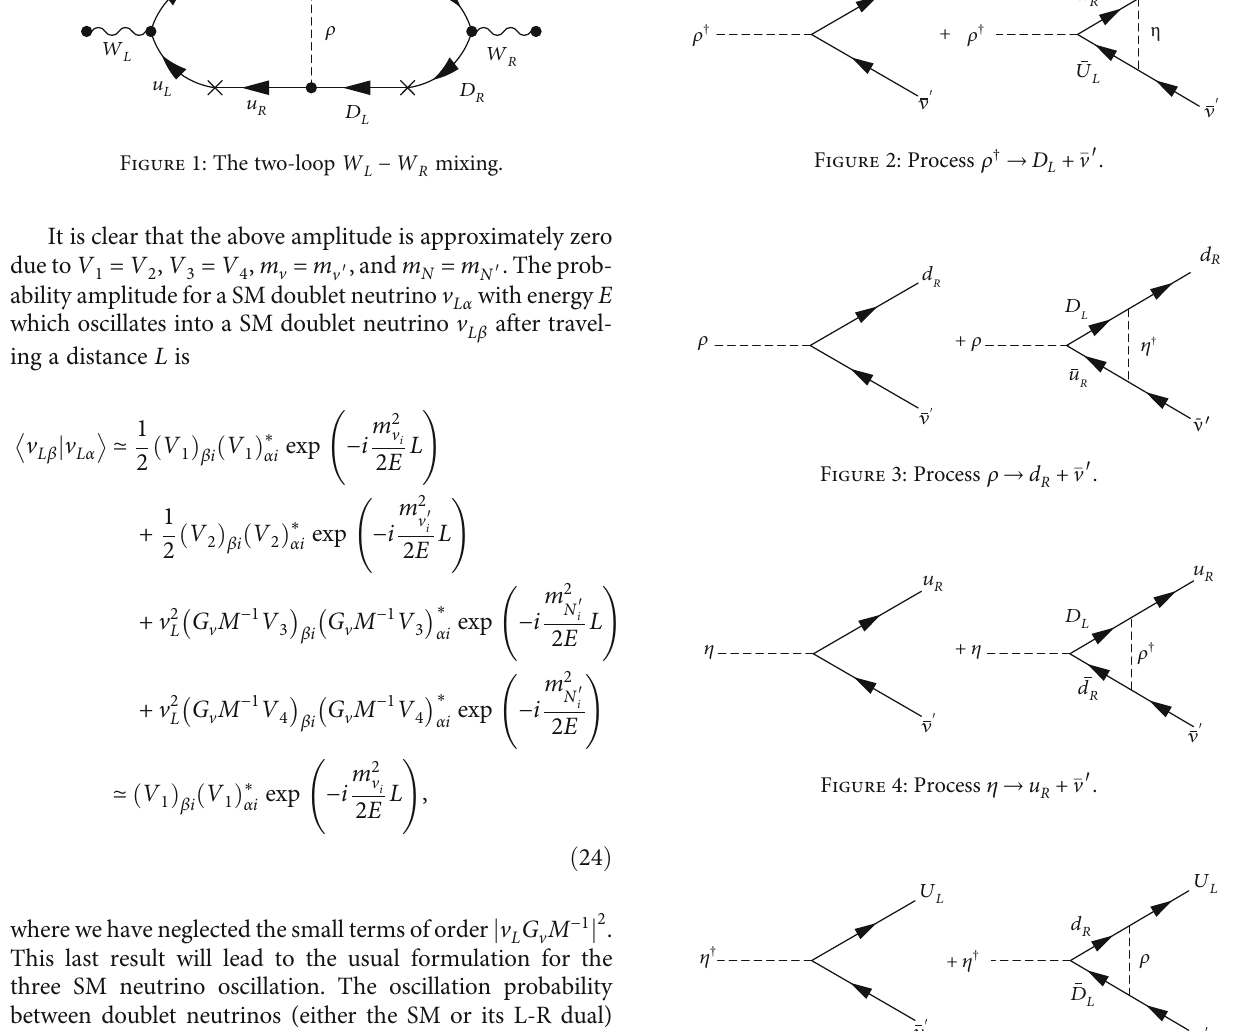
Figure 1: The two-loop W